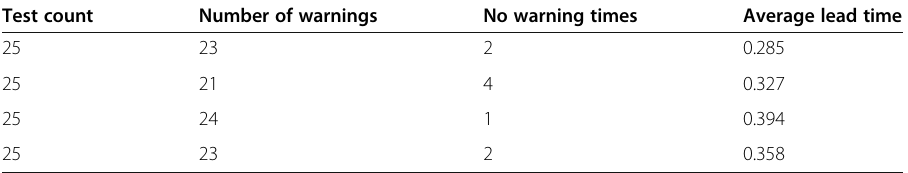
Table 2 Experimental results of multi-level threshold detection